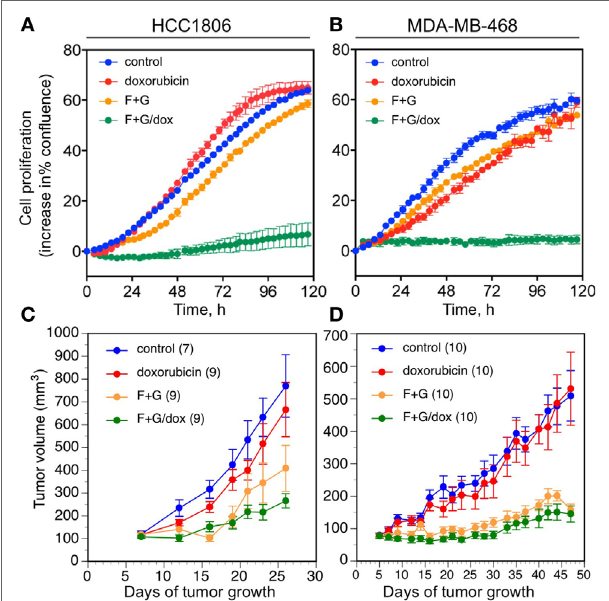
FigUre 6 | The effect of kinase inhibitors and doxorubicin on the proliferation of basal-like triple-negative breast cancer cells. (a,B) Cell culture studies using the IncuCyte live-cell imager. (a) HCC1806 cells; (B) MDA-MB-468 cells. Data are expressed as the change in percent confluence, corrected for confluence at time zero; mean values ± SEM at each time point, from triplicate wells for each treatment. Similar results were obtained in three replicate experiments for each cell line. Treatments are: control (blue); doxorubicin, 10 nM (red); fingolimod, 1 µM + gefitinib, 1 µM (F + G; orange); and F + G plus doxorubicin (green). (c,D) In vivo studies of orthotopic xenograft tumor growth in nude mice; mean values ± SEM, numbers in parentheses. (c) HCC1806 tumors. Repeated measures ANOVA up to day 26: overall effect of treatment, P = 0.003. Post hoc Tukey’s test: F + G vs. control, P = 0.036; F + G/dox vs. control, P = 0.004; F + G/dox vs. dox, P = 0.045. (D) MDA-MB-468 tumors. Repeated measures ANOVA up to day 47: overall effect of treatment, P < 0.001. Post hoc Tukey’s test: F + G vs. control, P = 0.001; F + G/dox vs. control, P < 0.001; F + G/dox vs. dox, P = 0.001. Treatments are: control (blue); doxorubicin, 2 mg/Kg (red); fingolimod, 5 mg/Kg + gefitinib, 25 mg/Kg (F + G; orange); and F + G plus doxorubicin (green). See Section “Materials and Methods” for further